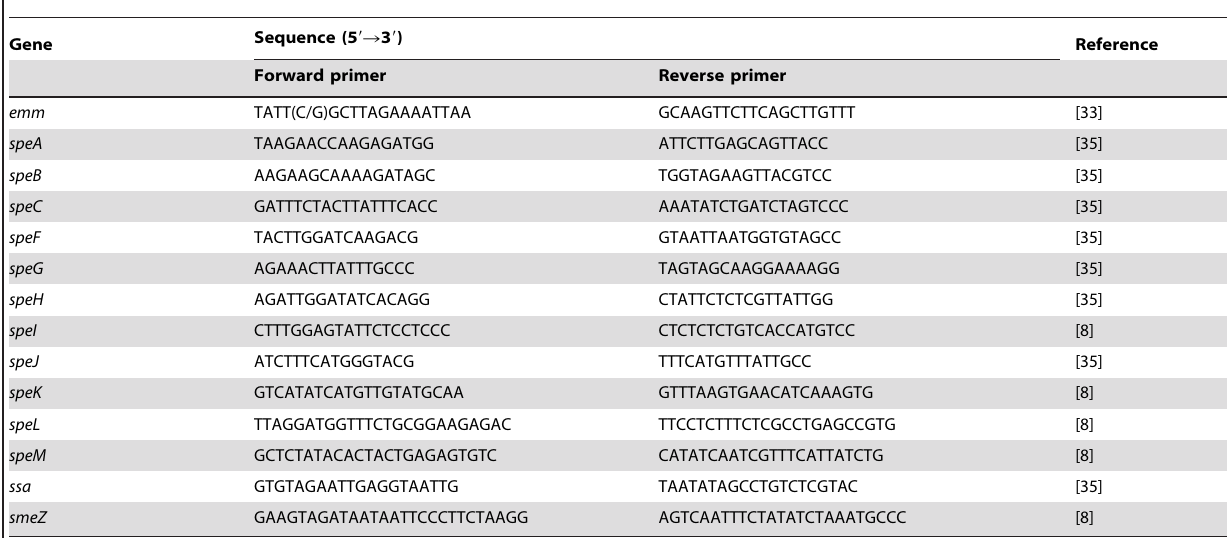
Table 1. List of Primers for Polymerase Chain Reaction Used in This